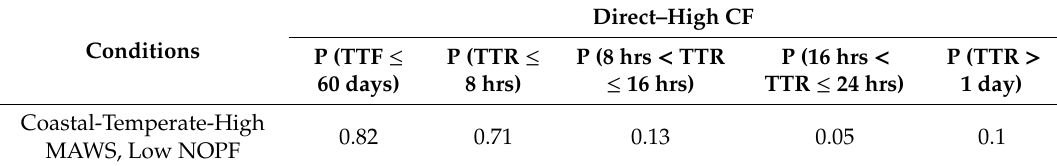
Table 3. Example of probabilities of time-to-failure (TTF) and time-to-repair (TTR) classes.